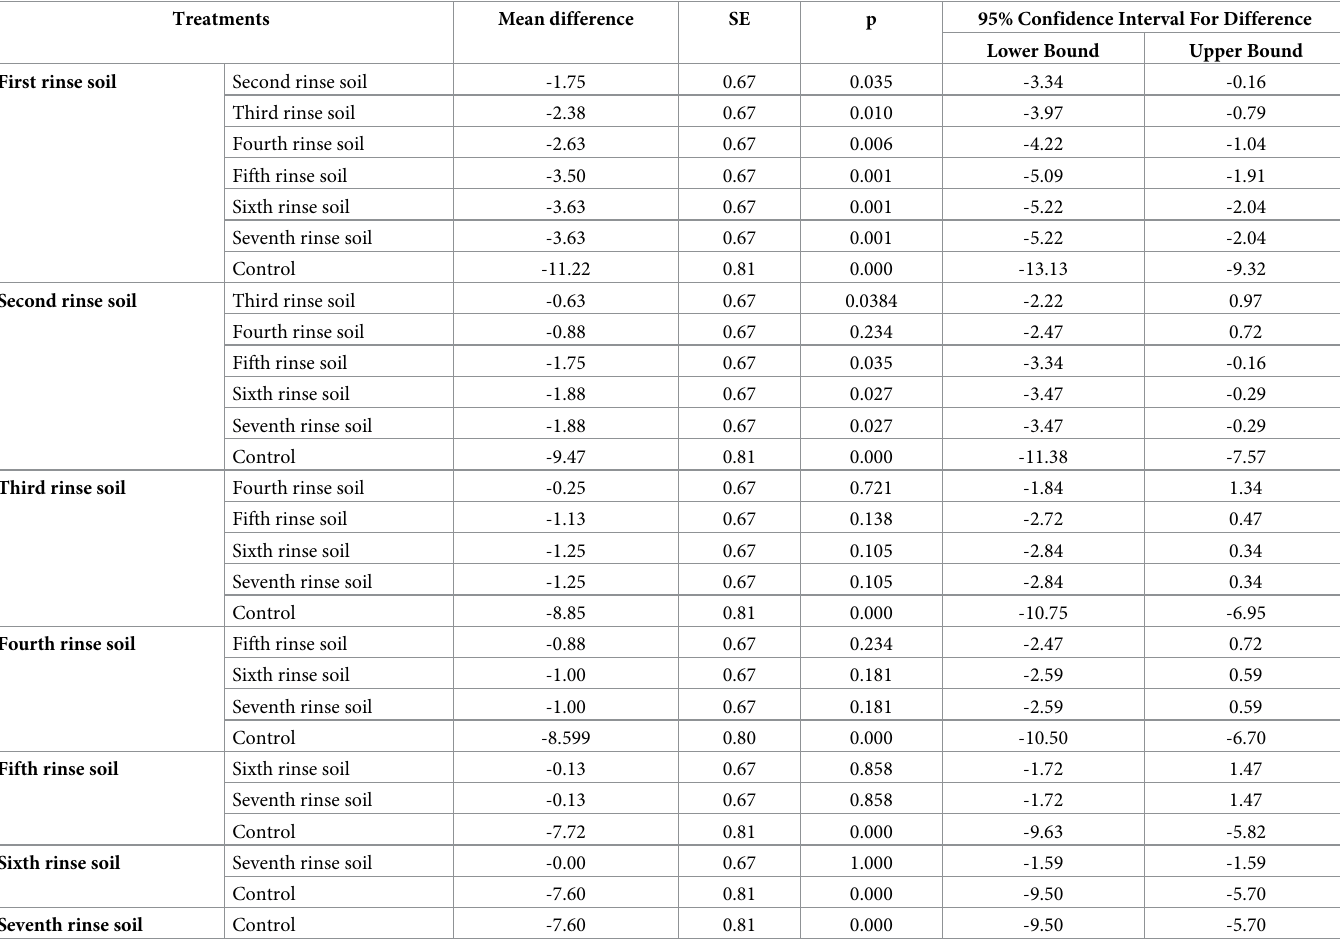
Table 4. Differences in the decrease in the number of bacteria between treatments.